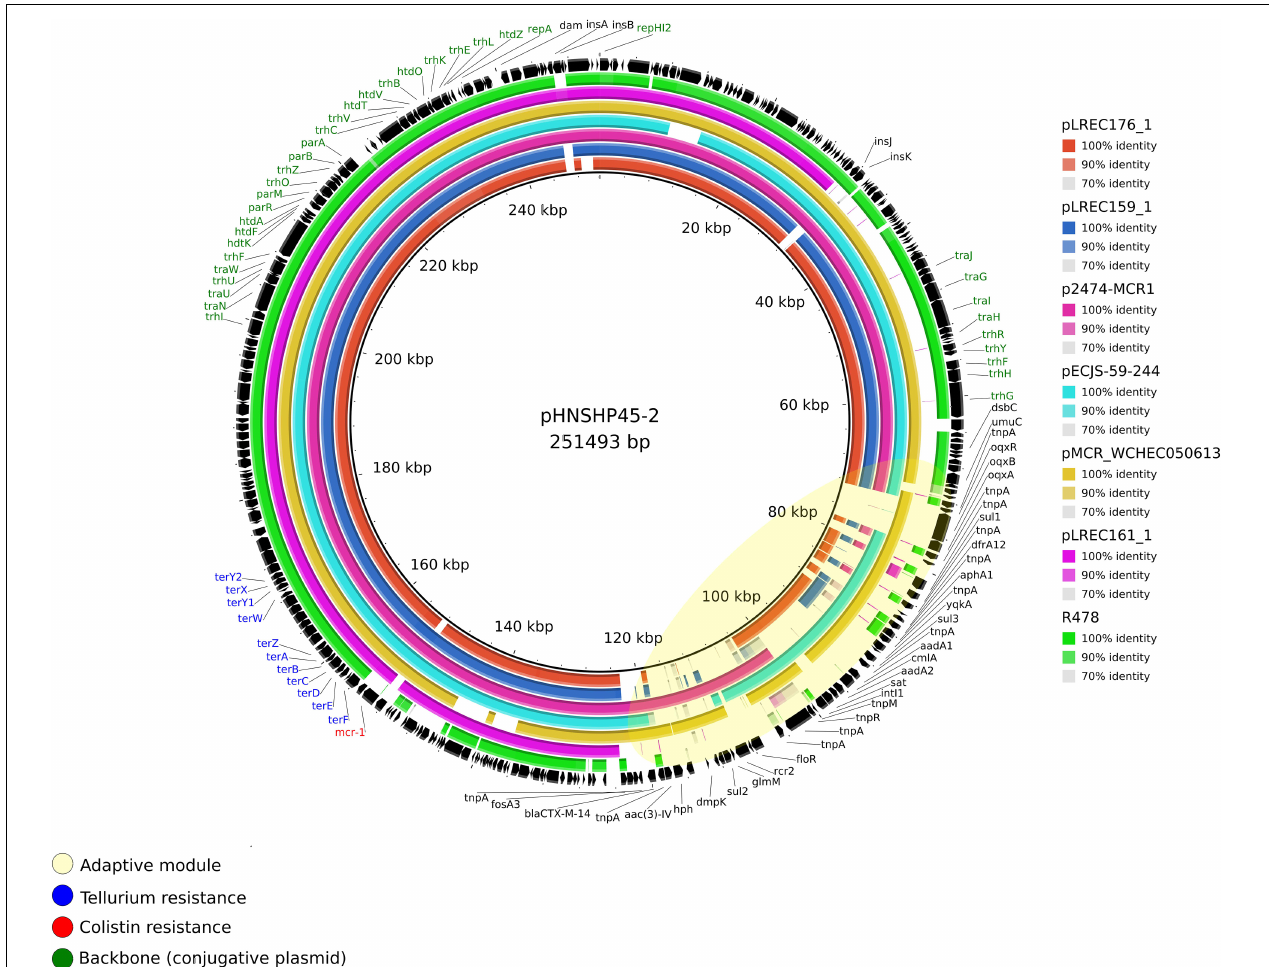
FIGURE 4 | Structural comparison between mcr-1 plasmids and IncHI2 references. The alignment includes four references and the mcr -1–bearing plasmids from our study pLREC176_1 and pLREC159_1, which are IncHI2 and pLREC161_1, which is an IncF plasmid with a presumptively IncHI2 cointegrated. The plasmid pHNSHP45-2 (IncHI2) was used as a reference to match with the other plasmids with [p2474-MCR1 (IncHI2), pECJS-59-244 (IncHI2), and pMCR_WCHEC050613 (IncHI2)] and without the mcr-1 gene [R478 (IncHI2)]. The outer circle with black arrows denotes the annotation of reference sequence pHNSHP45-2. The image was generated using BRIG (default parameters with 90/70 as upper/lower